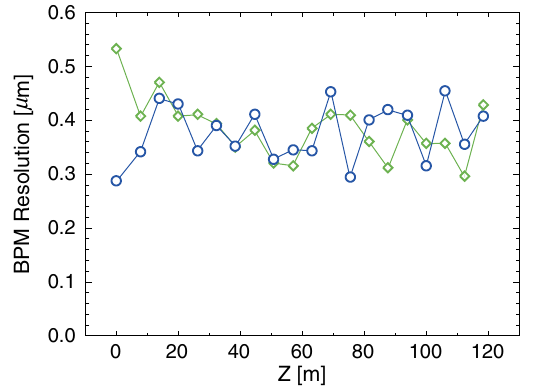
FIG. 6. Position resolution data along the 20 BPMs in the undulator beam line. The blue circles show the X resolutions and the green circles are the Y resolutions. The resolutions are less than 0 : 6 (cid:1) m (STD).